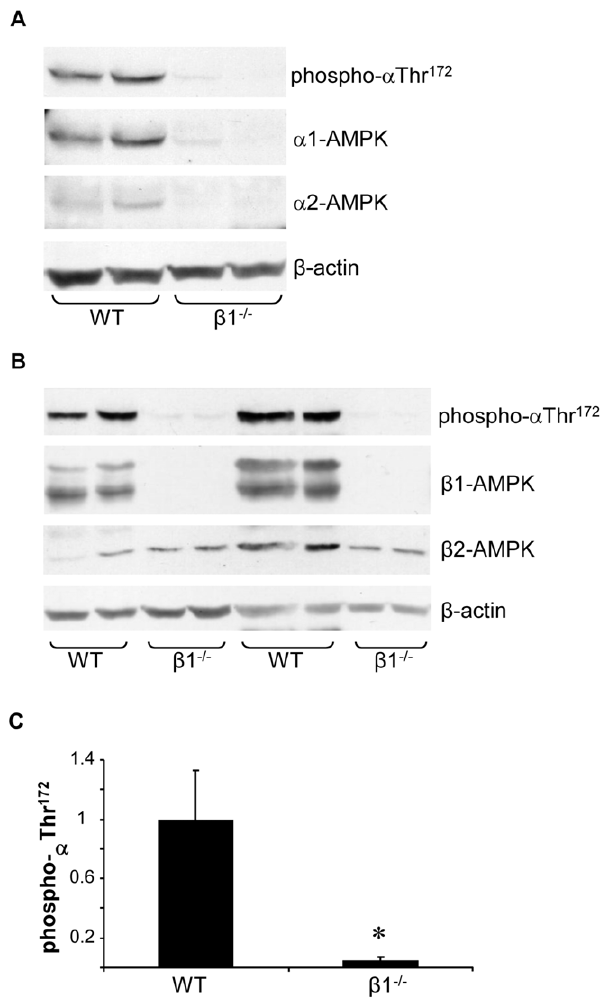
Figure 2. Renal expression of activated AMPK is markedly reduced in AMPK- b 1 2 / 2 mice. A and B. Lysate from WT and AMPK- b 1 2 / 2 kidneys were analyzed by Western blot for the activated form of AMPK, phosphorylated at Thr 172 of the catalytic ( a ) subunit. The membrane was stripped and reblotted to determine expression of the catalytic ( a 1 and a 2) (A) and scaffolding ( b 1 and b 2) (B) subunits of AMPK. Expression of b -actin was determined to confirm even sample loading. C. Expression of activated (phospho- a Thr 172 ) in kidneys from WT and AMPK- b 1 2 / 2 mice was quantified by densitometry using arbitrary units (n=6 per group). Densitometry for phospho- a Thr 172 was corrected for b -actin. * P , 0.001 by unpaired t test.